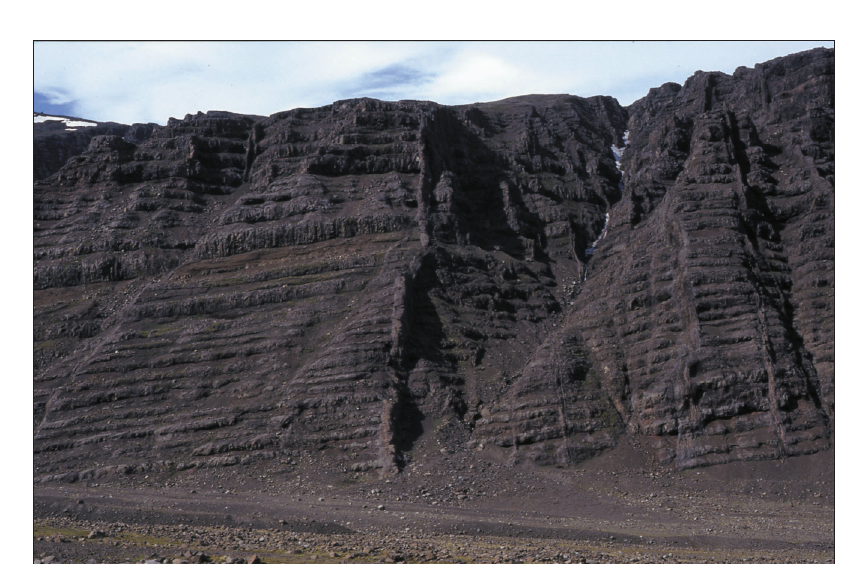
Fig. 1. 400 m thick Tertiary pile of lava flows, sediments and pyroclastic rocks in the valley of Vidbordsdalur in Southeast Iceland. View northeast, the general dip of the pile increases by 2-3° from its top to the bottom. The pile is dissected by dykes, some of which are arrested, that reach thicknesses of up to 13 m.